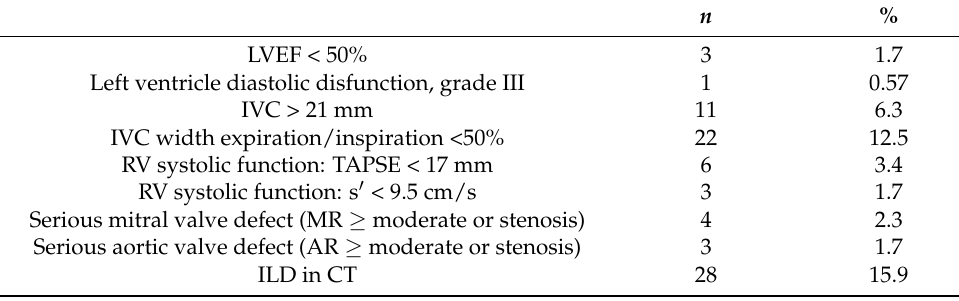
Table 2. Analysis of echocardiographic findings in the study group ( n =